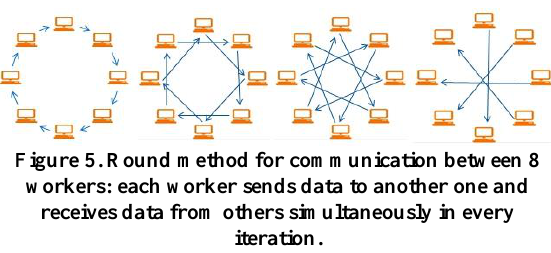
Figure 5. Round method for communication between 8 workers: each worker sends data to another one and receives data from others simultaneously in every iteration.